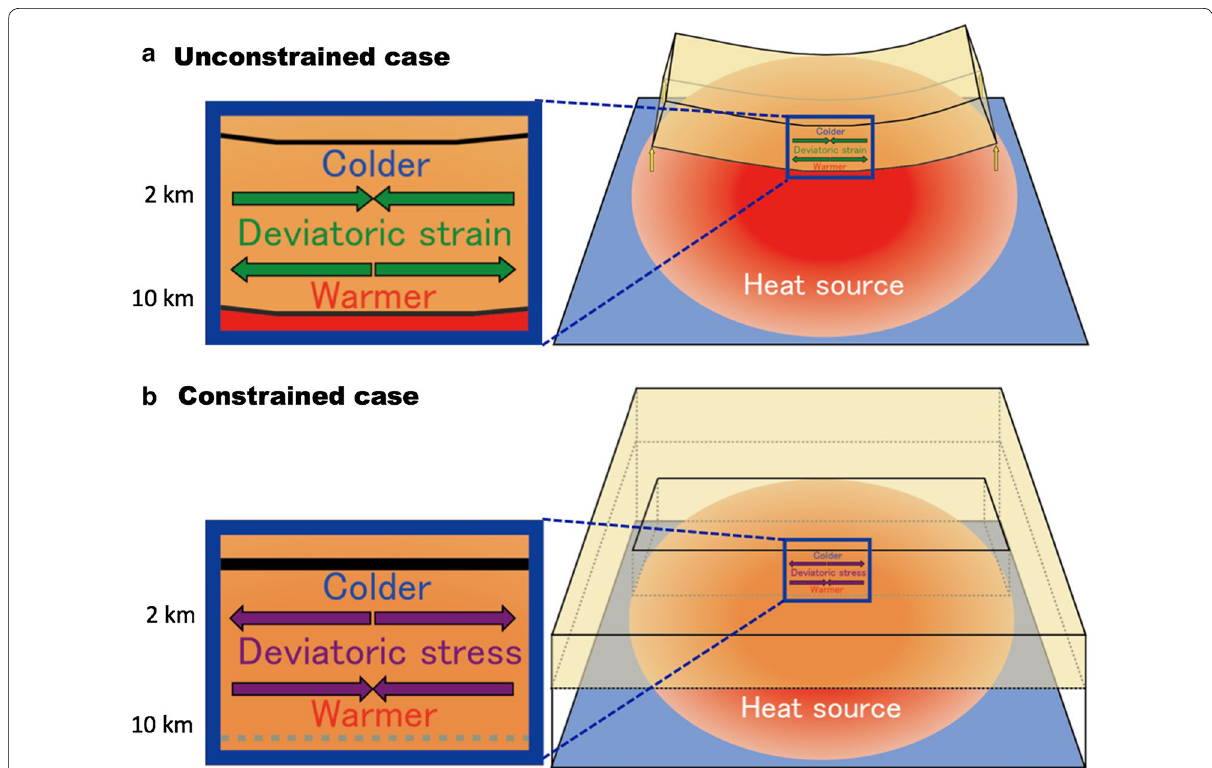
Fig. 10 Schematic depth distribution of stress due to a deep heat source. Close-up of the central vertical plane (blue rectangle) is shown to the left of each figure. a If a rock block is located above a heat source, and the block can be freely deformed, the bottom half of the block will expand due to heating. In this case, horizontal deviatoric strain is contraction in the shallower part and dilatation in the lower part as indicated by green arrows. Note that this strain is not the elastic strain but the thermal one causing no stress change. b In the crust, however, the block cannot be freely deformed, but becomes locked at each end. Horizontal deviatoric stress becomes compressional in the bottom half and tensional in the top half as indicated by purple arrows. Note that the vertical deviatoric strain and stress are not plotted in the figure, for the sake of simplicity. Here we presume that hot water or partial melt is acting as a heat source as proposed by Yoshida et al. (2011) and Kato et al.